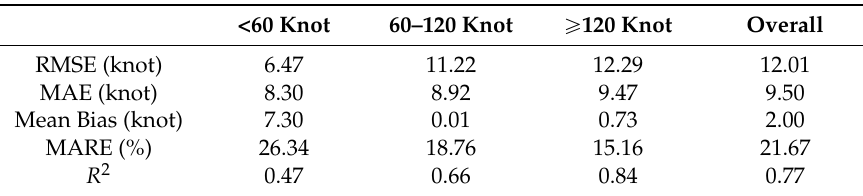
Figure 8. The sequences of the intensity of the 52 typhoons divided into three groups. The gray line indicates the best-track intensities and the black line represents the model estimated ones.